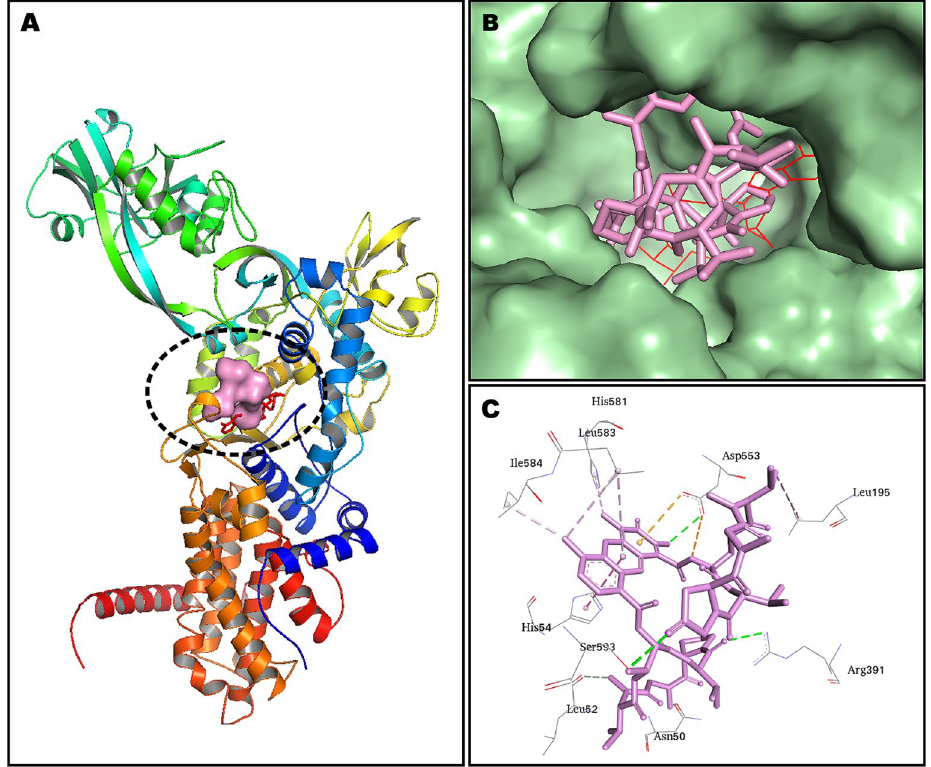
Figure 11. Minimum energy conformation of docked compound K 1 in the binding pocket of isoleucyl- tRNA synthetase (IleRS). ( A ) IleRS has been shown as cartoon representation while docked compound K 1 has been shown as a surface in pink color; ( B ) Binding pocket of IleRS has been shown as surface and docked compound K 2 is represented as a stick in pink while native ligand is demonstrated as line rendering in red color; ( C ) Binding residues are shown inline style and intermolecular interaction are shown as dotted lines. PyMoL 2.4.1 (https:// pymol. org/2/) ( A , B ) and Biovia Discovery Studio Visualizer 2020 (C) programs were used for generating the